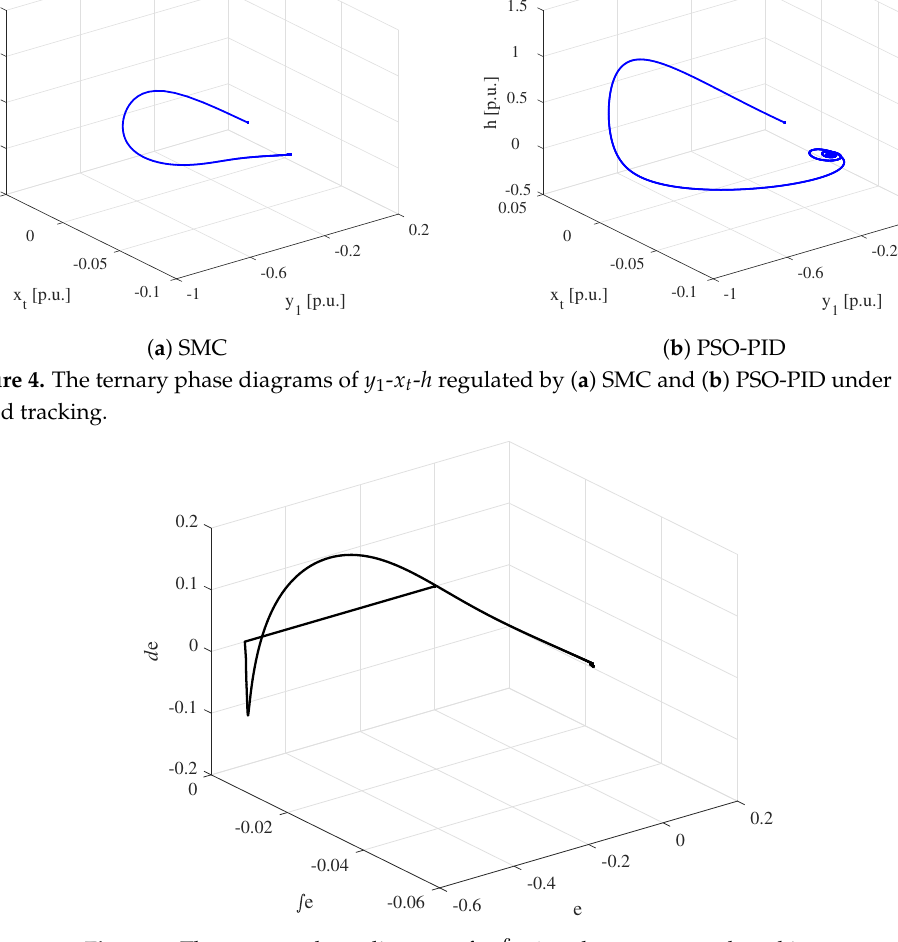
Figure 5. The ternary phase diagram of e -